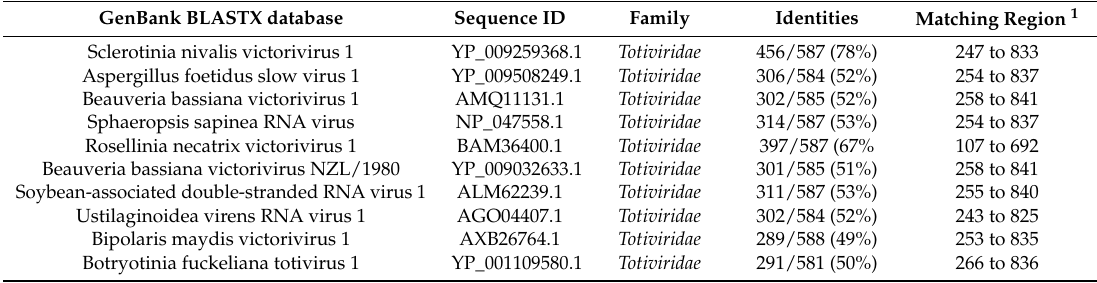
Table 3. BLASTX comparison of a 1852 bp RdRp sequence obtained from cloning 5 kb dsRNA of 06P G. abietina